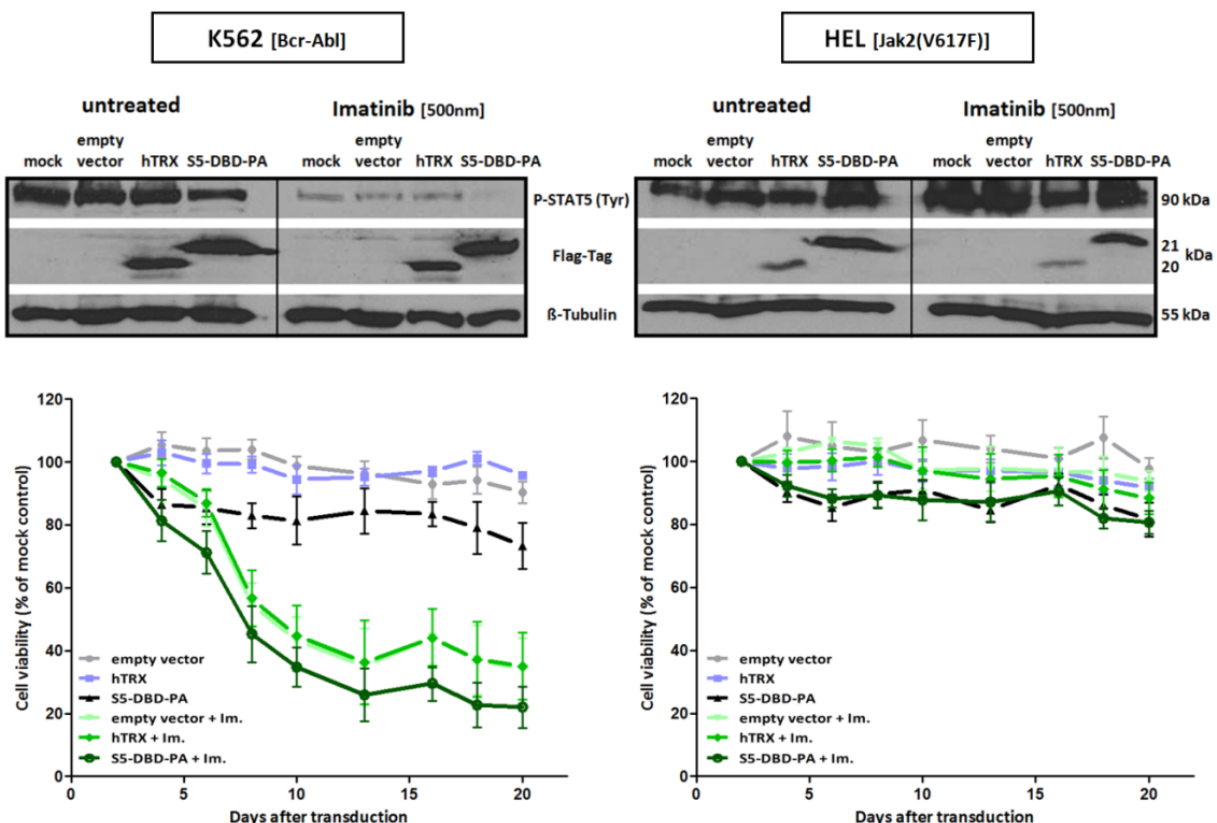
Figure 10. Combined imatinib and S5-DBD-PA treatment synergize in death induction of Bcr-Abl + K562 cells. 2 days after the lentiviral transduction of S5-DBD-PA, the hTRX scaffold or empty vector (SiEW) K562 cells were cultured without or with imatinib (f.c.: 500 nM). Protein construct expression and the influence of combined S5-DBD-PA and imatinib treatment on P-Stat5 protein levels were analyzed by western blotting with Flag-tag and P-Stat5 specific antibodies. The lysates were prepared after 5 days of imatinib treatment. Cell growth and viability were assayed by XTT conversion from the start of imatinib treatment (day 2 after infection) till day 20 after infection ( n = 3; Ø ± SD). The incubation of the HEL cell line served as a control of Bcr-Abl specific inhibition through